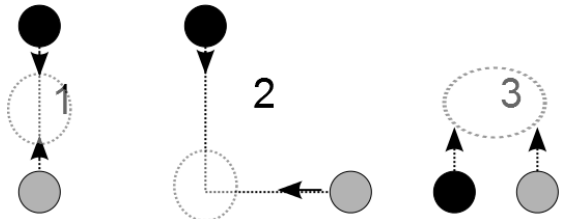
Figure 2. The three F-formations [15]: 1. Vis-a-vis, 2. L-shape and 3. Side- by-side. The dotted ovals denote the shared interaction space, the